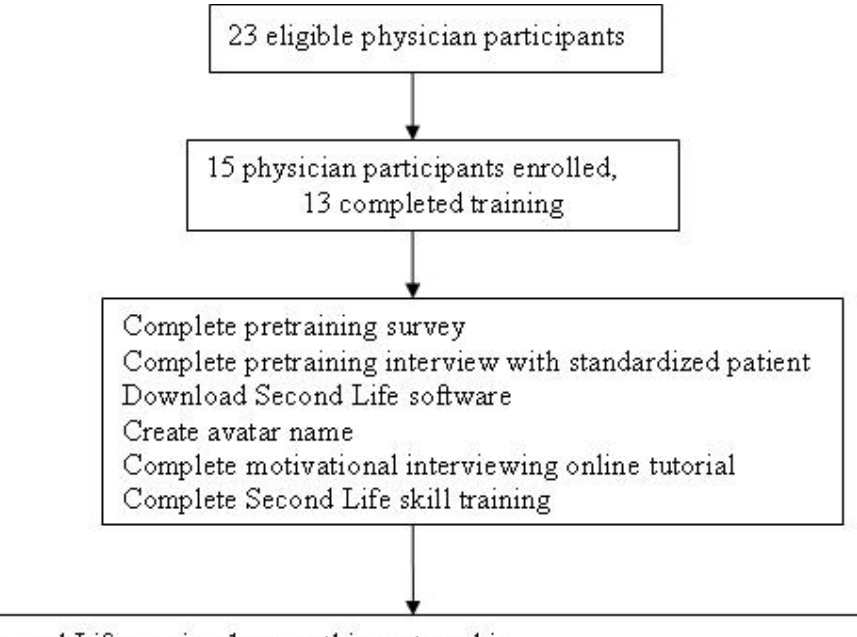
Figure 1. Recruitment and instructional design (VASE-R = video assessment of simulated